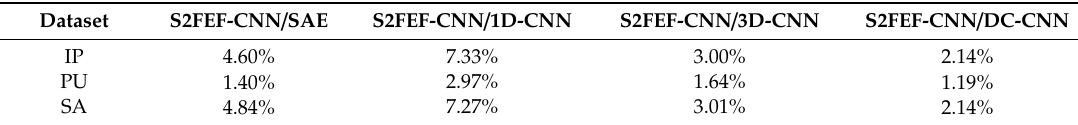
Table 4. The parameter percentage of di ff erent